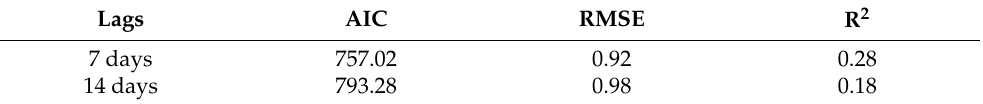
Table 1. Comparison between lag days based on AIC, RMSE, and R-squared.